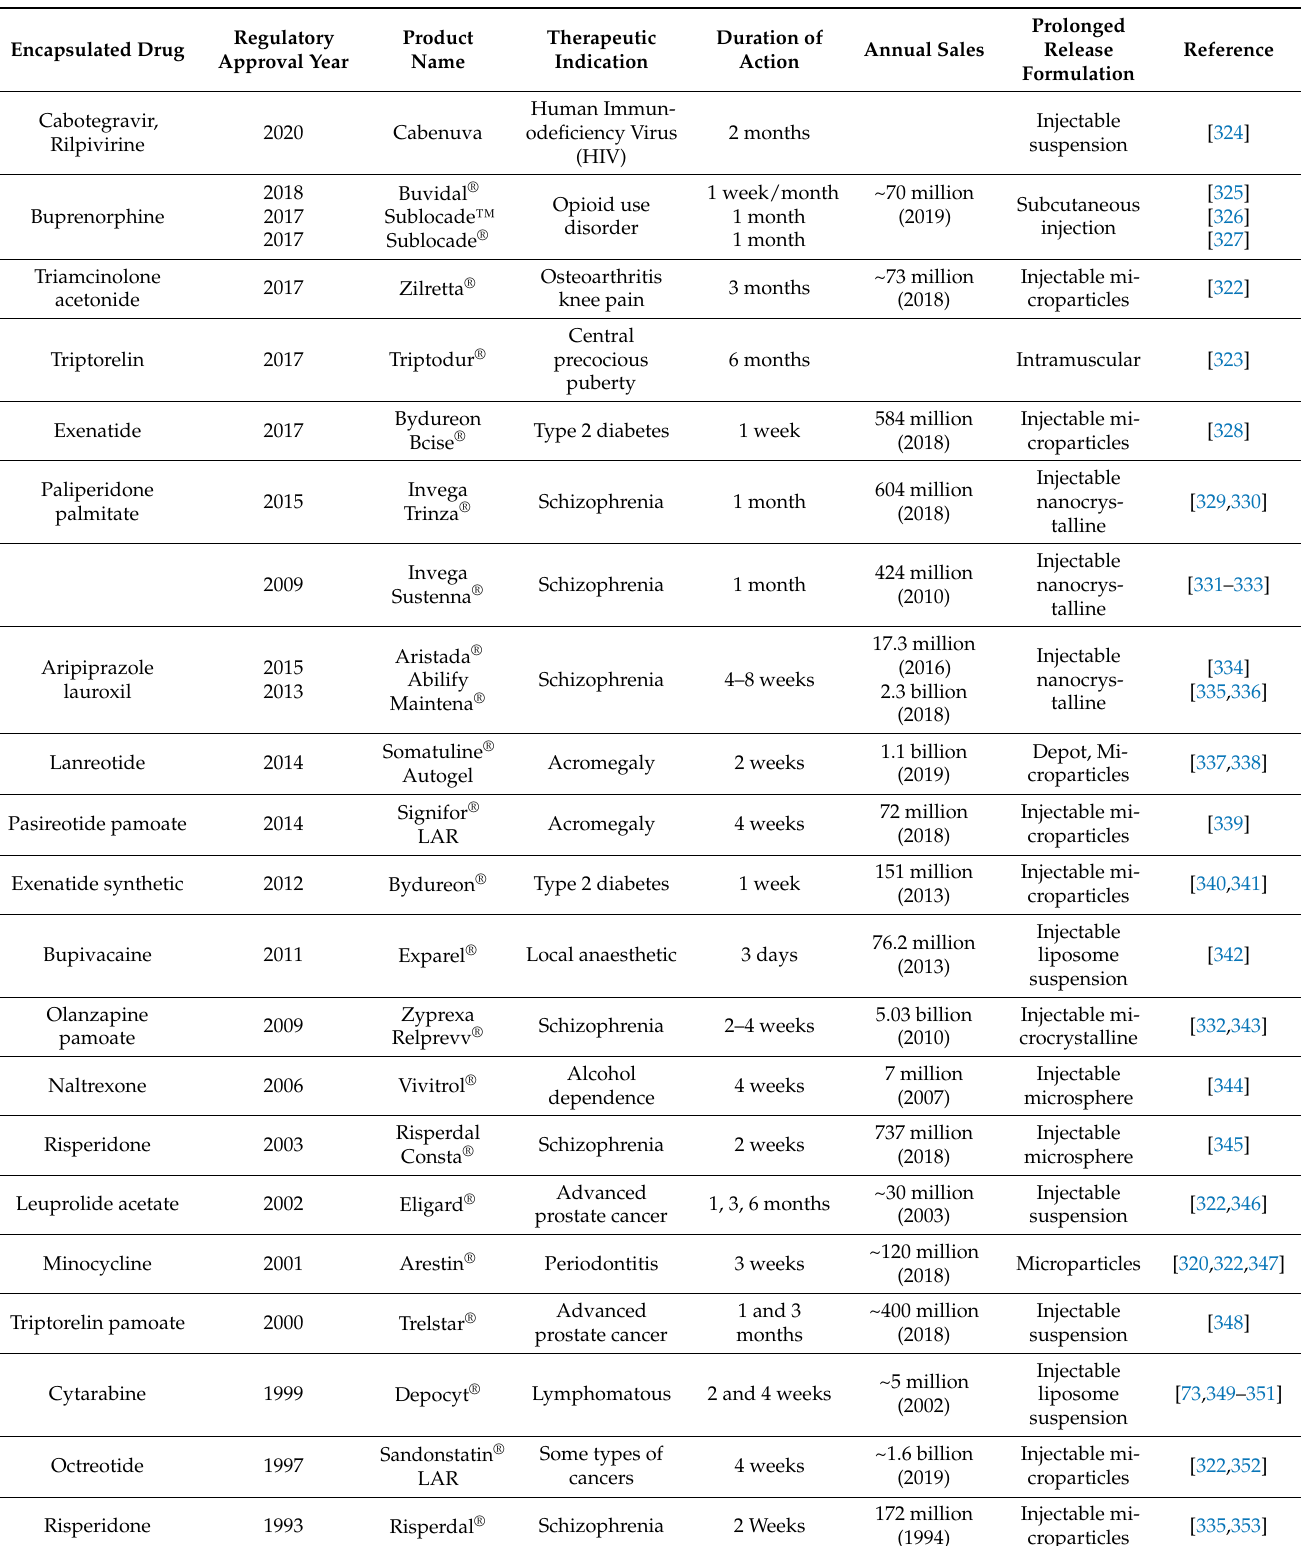
Table 2. Prolonged-release products involving drugs encapsulated in biopolymer formulations and that have received regulatory